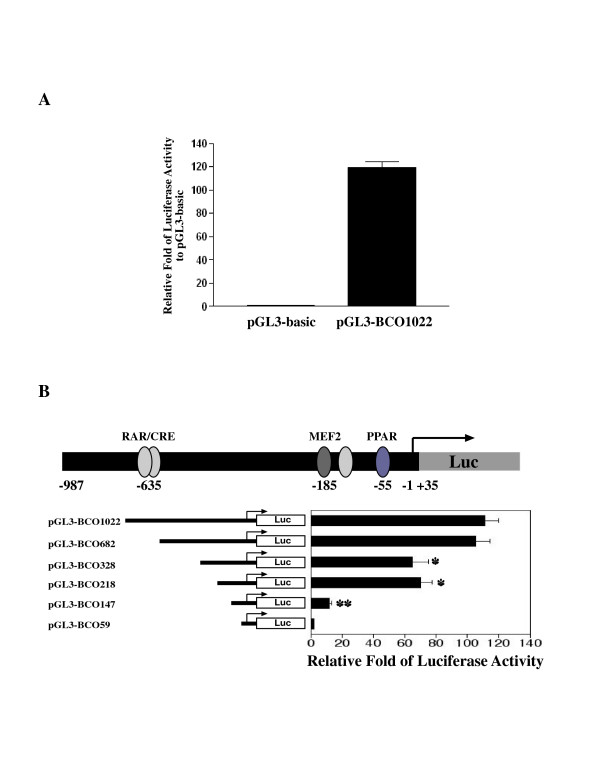
Mapping of the regulatory elements in the BCMO1 promoter in TC-7 cells. A. Transactivating activity of human BCMO1 promoter. A 1022-bp fragment was used for the construction of the BCMO1 reporter plasmid, pGL3-BCO1022, as described in "Methods". Luciferase activity was measured in total cell extracts obtained from TC-7 cells 24 h after transient transfection and compared with cellular luciferase activity for transfection of the control empty vector, pGL3-basic. B. Above, a schematic diagram of the BCMO1 promoter reporter construct (pGL3-BCO1022) showing the location of putative transcription factor binding sites. Below, deletion analysis of the BCMO1 -987/+35 promoter fragment. TC-7 cells were transiently transfected with luciferase reporter constructs containing serial deletions of BCMO1 5'-flanking DNA. Cells were transfected with reporter constructs (0.3 μg/well) and a β-Gal expression vector was added as an internal control. After 24 h, cells were lysed and luciferase and β-Gal activities were measured. Results are means ± S.D. of three or more independent experiments each performed in triplicate. *, p < 0.05, **, p < 0.001.